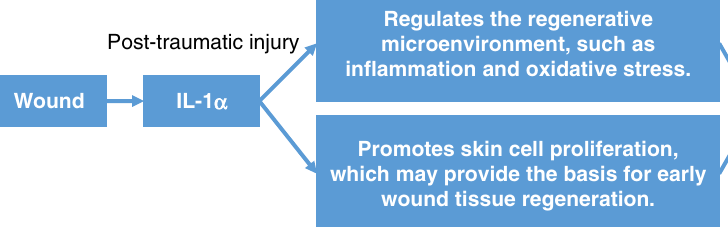
Fig. 10 Schematic diagram of IL-1α promoting de novo hair follicle regeneration after